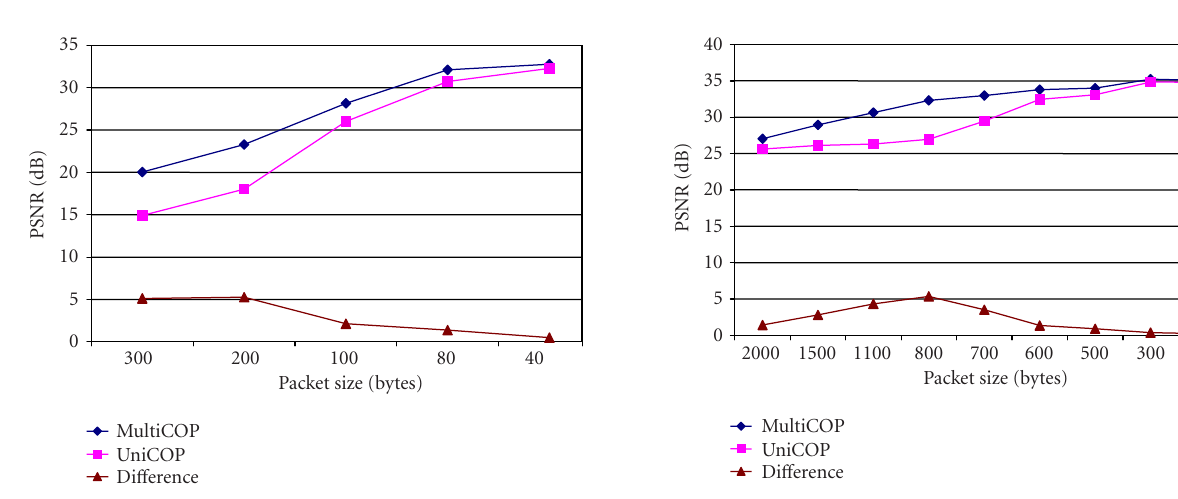
Figure 9: Comparative performance between UniCOP and Multi- COP assignment strategies with (cid:1) = 10 − 3 .